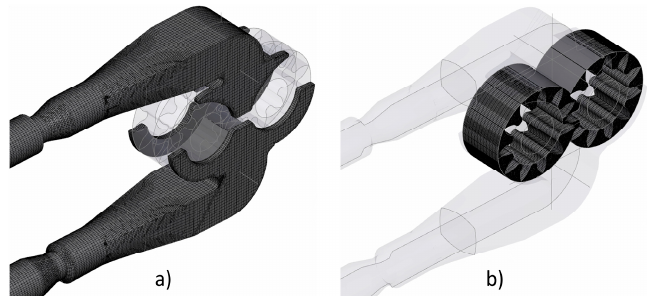
Figure 4. The computational mesh of the gear pump: ( a ) suction and delivery ports, and ( b ) rotating wheels equipped with hexahedral mesh elements.